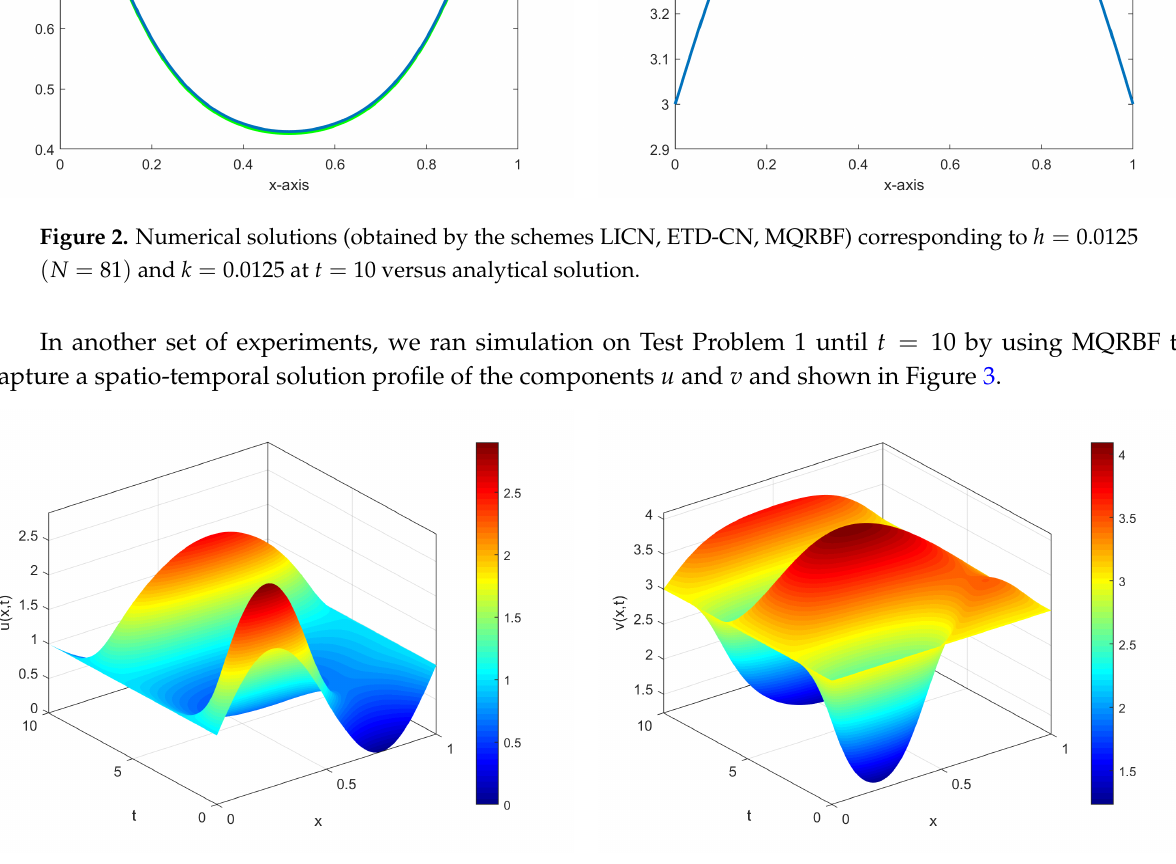
Figure 3. Numerical solution obtained by MQRBF scheme for u and v corresponding to ( N = 81 ) and k = 0.0125 until t =